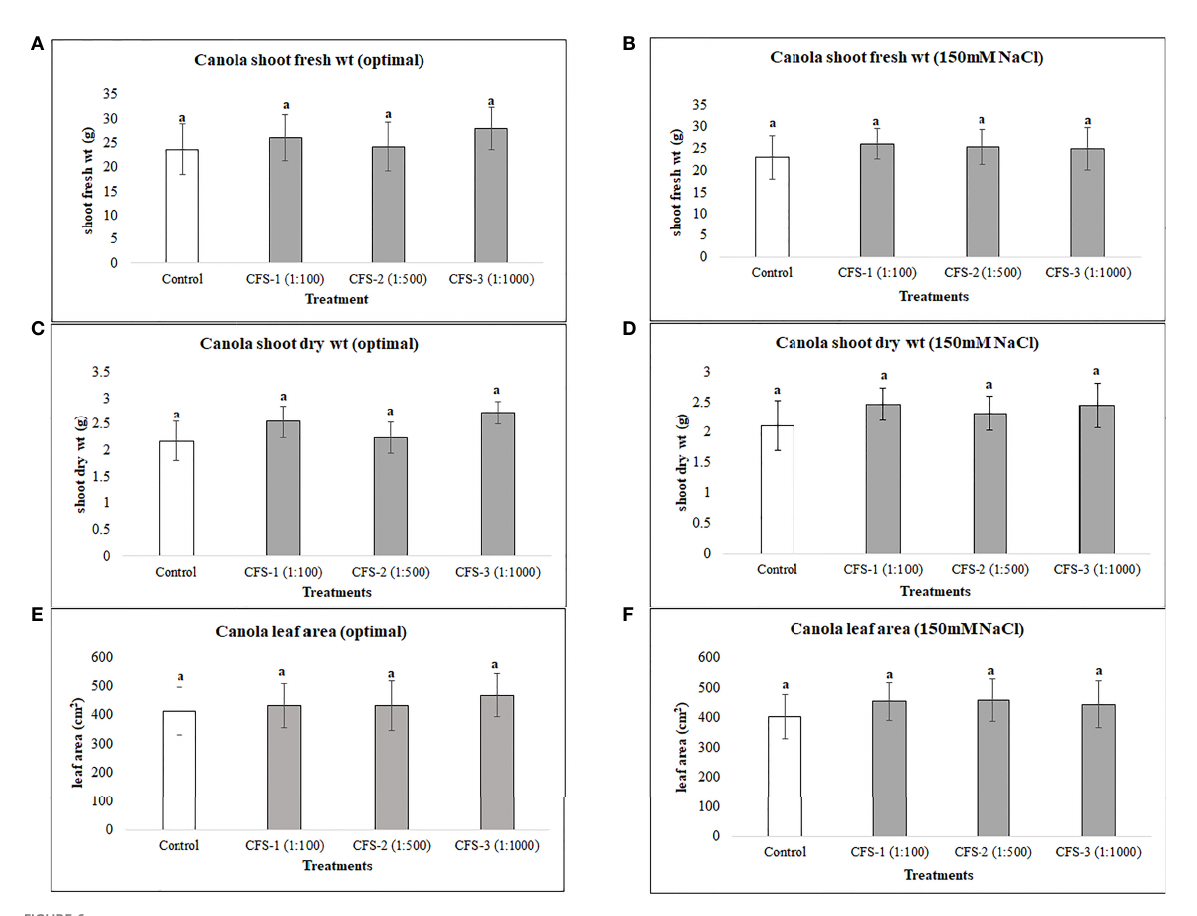
FIGURE 6 Canola above ground biomass affected by CFS (A) shoot fresh wt - optimal (B) shoot fresh wt – 150 mM NaCl (C) shoot dry wt - optimal (D) shoot dry wt – 150 mM NaCl (E) leaf area - optimal (F) leaf area – 150 mM NaCl. The data represents the mean values of 8 replications (n=8) ± standard error. Different letters indicate values determined by Tukey ’ s multiple mean comparison to be signi fi cantly different (p< 0.05) from each